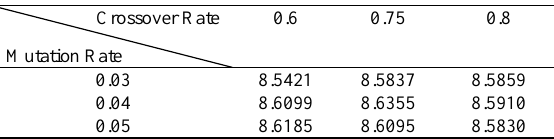
Table 6. Profit rate under various values of GA operators ( d t =6mm, T